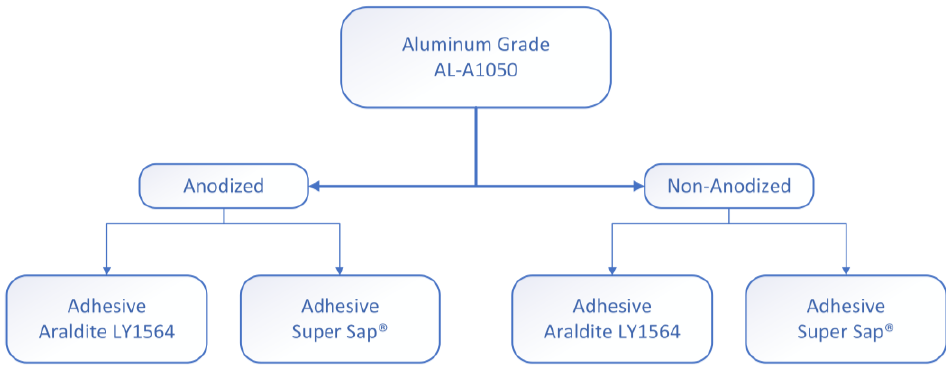
Figure 3. The four different types of single-lap joints manufactured and tested.